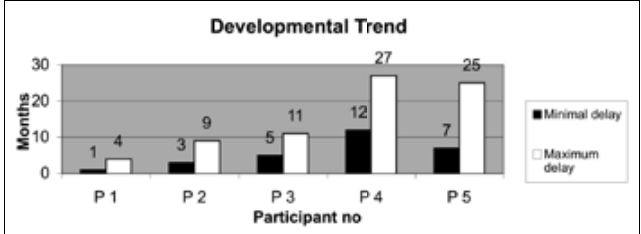
Fig. 6. Collective developmental trend emerging from the five participants.